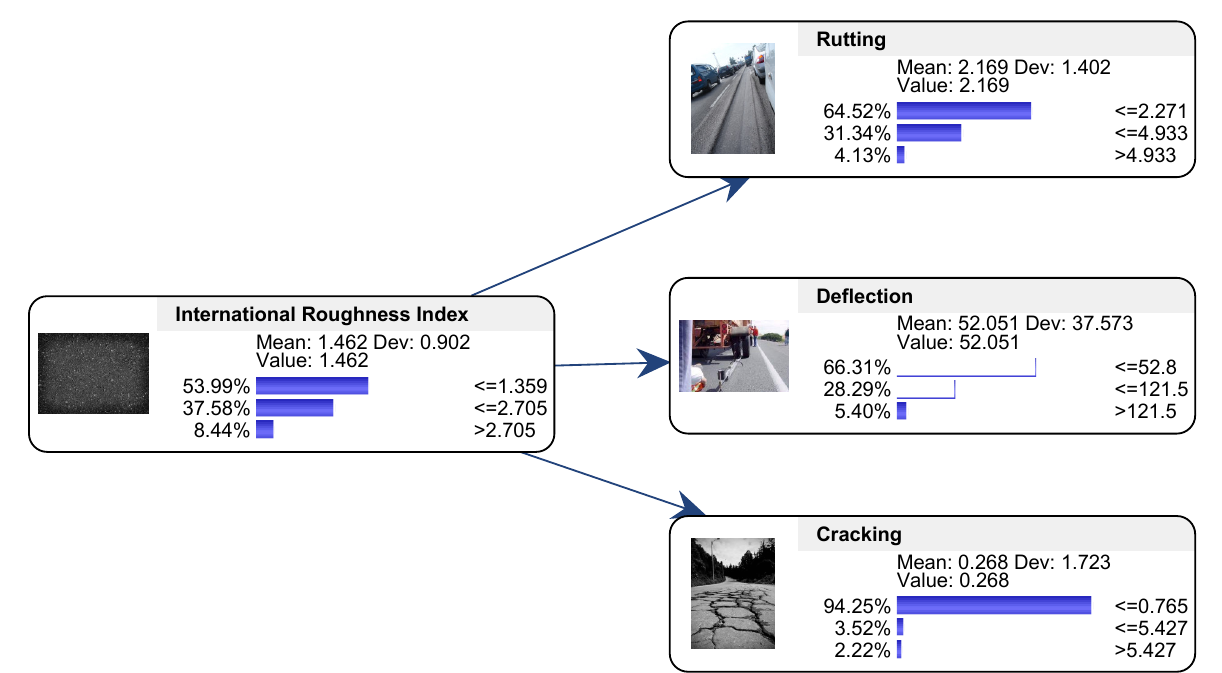
Figure 7. Bayesian network structure. Table 4. An example of selecting the optimum Bayesian